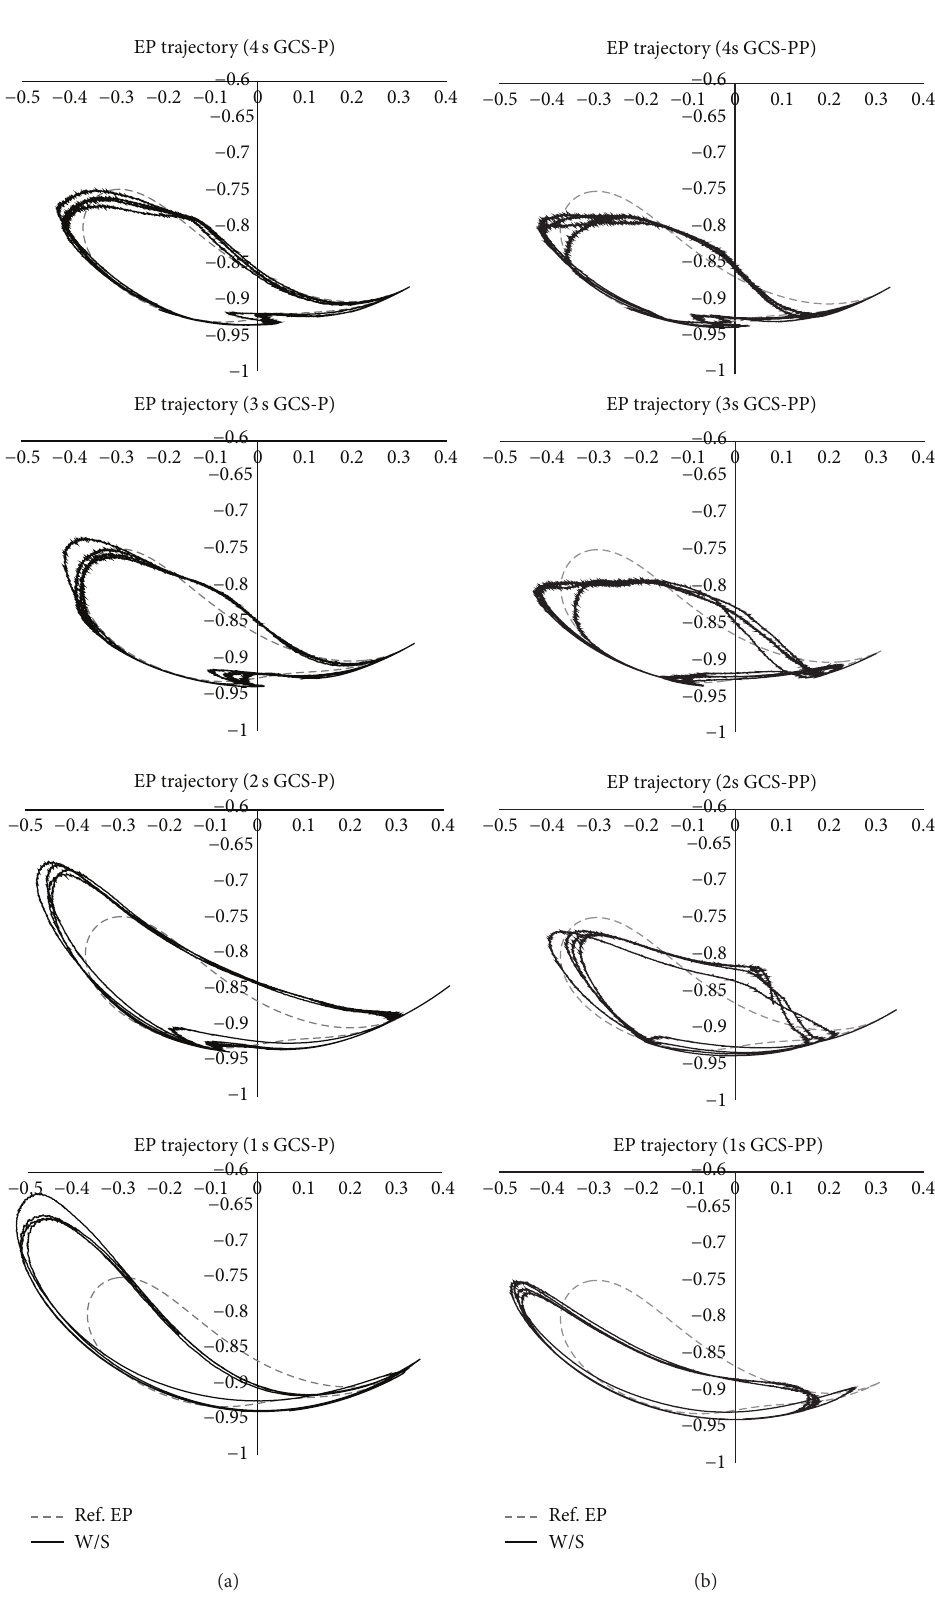
Figure 13: End point trajectory for the leg orthosis W/S using cocontraction model based P and PP